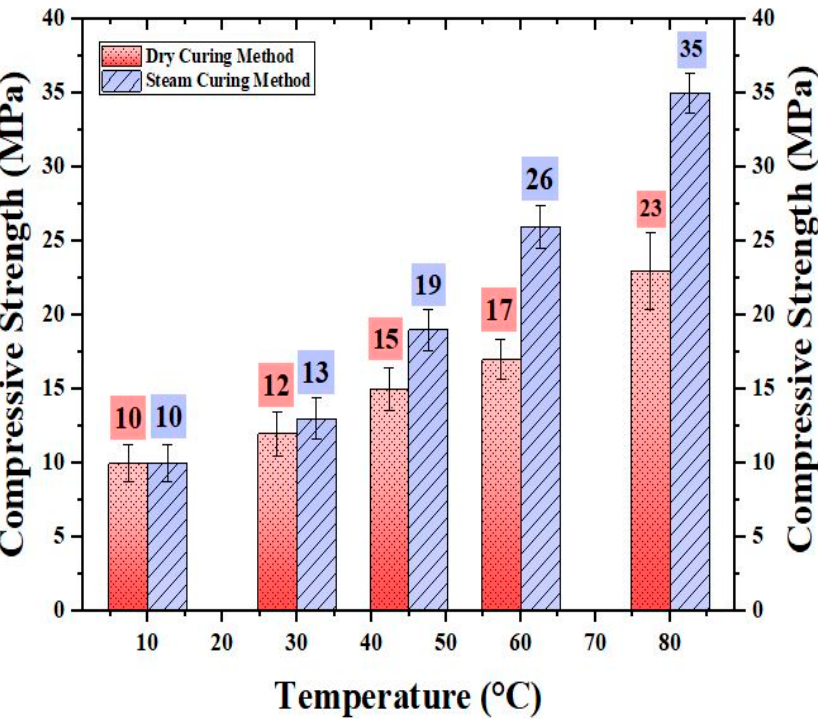
Figure 4. Average compressive strength of steam-cured geopolymer concrete (GPC) samples.